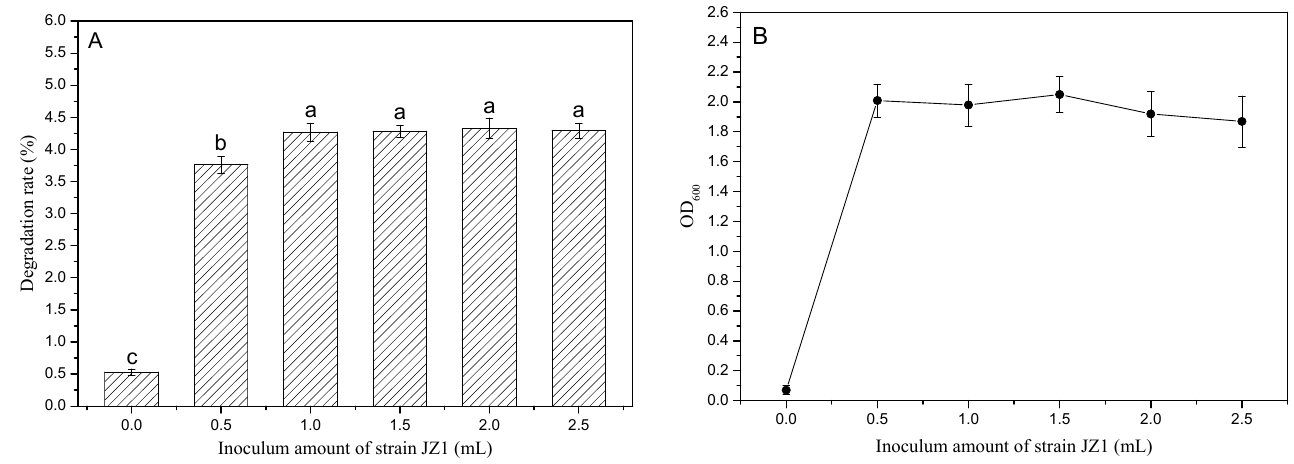
Figure 5. Effect of different inoculation amounts on degradation rate of PBAT film ( A ) and the change of biomass (OD 600 ) in the medium ( B ); a-c are symbols indicating the significance of the dif-